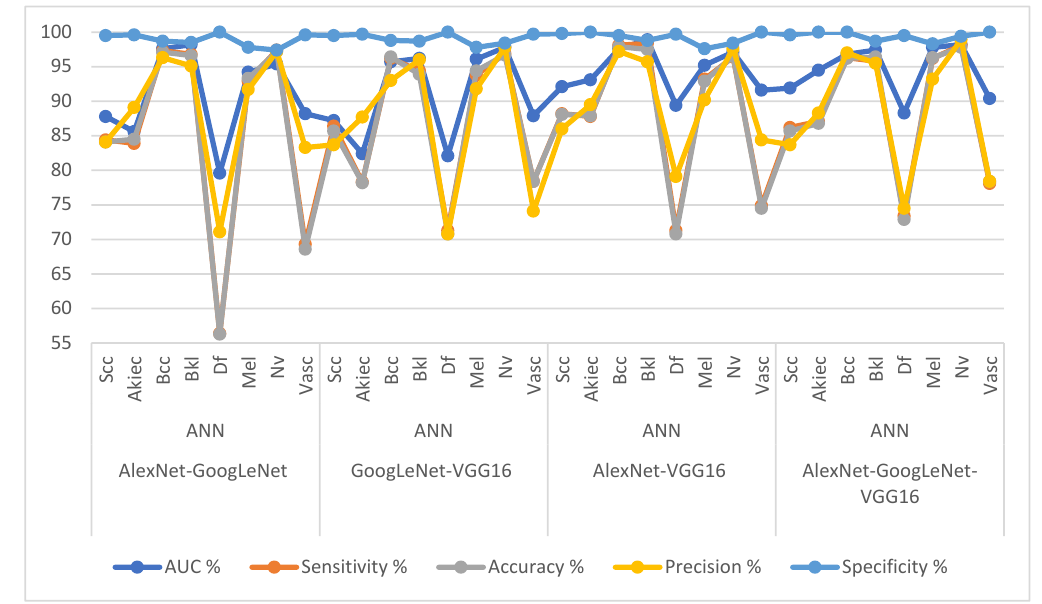
Akiec 82.5 80.1 Figure 13. Display Performance results of CNN-ANN hybrid models based on the fused CNN models for early diagnosis and discrimination of skin cancer and other skin lesions. Table 8 and Figure 14 present the measurement performance of the CNN-ANN hybrid models based on the fused CNN models for image analysis of the ISIC 2019 dataset for the early diagnosis of skin lesions as follows: the AlexNet-GoogLeNet-RF model achieved average results: an AUC of 91.69%, sensitivity of 85.03%, accuracy of 95.3%, precision of 86.16%, and specificity of 99.15%. The GoogLeNet-VGG16-RF model achieved average results: an AUC of 92.40%, sensitivity of 87.51%, accuracy of 95.30%, precision of 87.80%, and specificity of 99.30%. The AlexNet-VGG16-RF model achieved average results: an AUC of 90.89%, sensitivity of 86.81%, accuracy of 94.30%, precision of 85.45%, and specificity of 99.08%. The AlexNet-GoogLeNet-VGG16-RF model yielded average results: an AUC of 90.33%, sensitivity of 86.54%, accuracy of 95.70%, precision of 86.76%, and specificity of 99.30%. Table 8. Performance results of CNN-RF hybrid models based on the fused CNN models for early diagnosis and differentiation of skin cancer and other skin lesions.